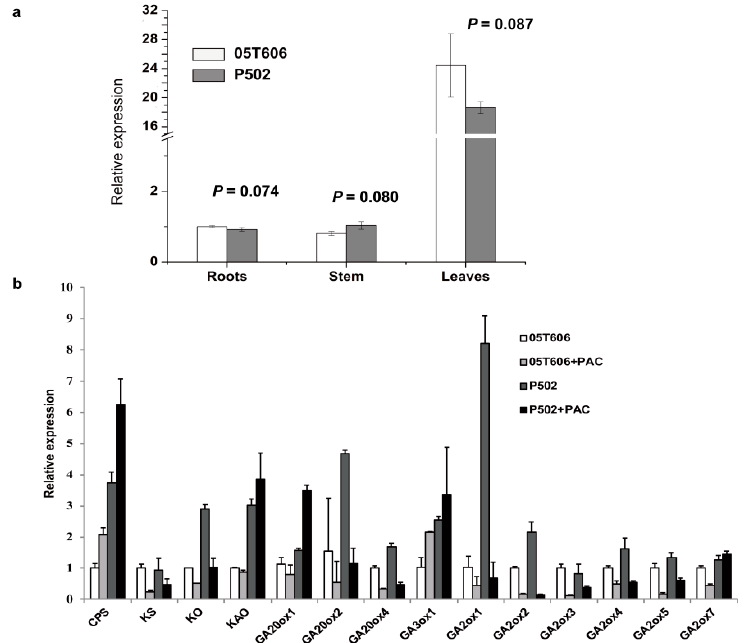
Figure 7. Expression analysis in the qRT-PCR assay. ( a ) Expression patterns of EI in the roots, stem, and leaves of P502 and the wild-type. Total RNA was isolated from P502 and wild-type at 40-day-old seedlings. A Student’s t test was used for statistical analysis. ( b ) Expression levels of the GA biosynthetic genes after 10 − 7 M paclobutrazol (PAC, GA biosynthesis inhibitor) treatment. Data represent mean ± SD based on three independent biological and three technical experiments.